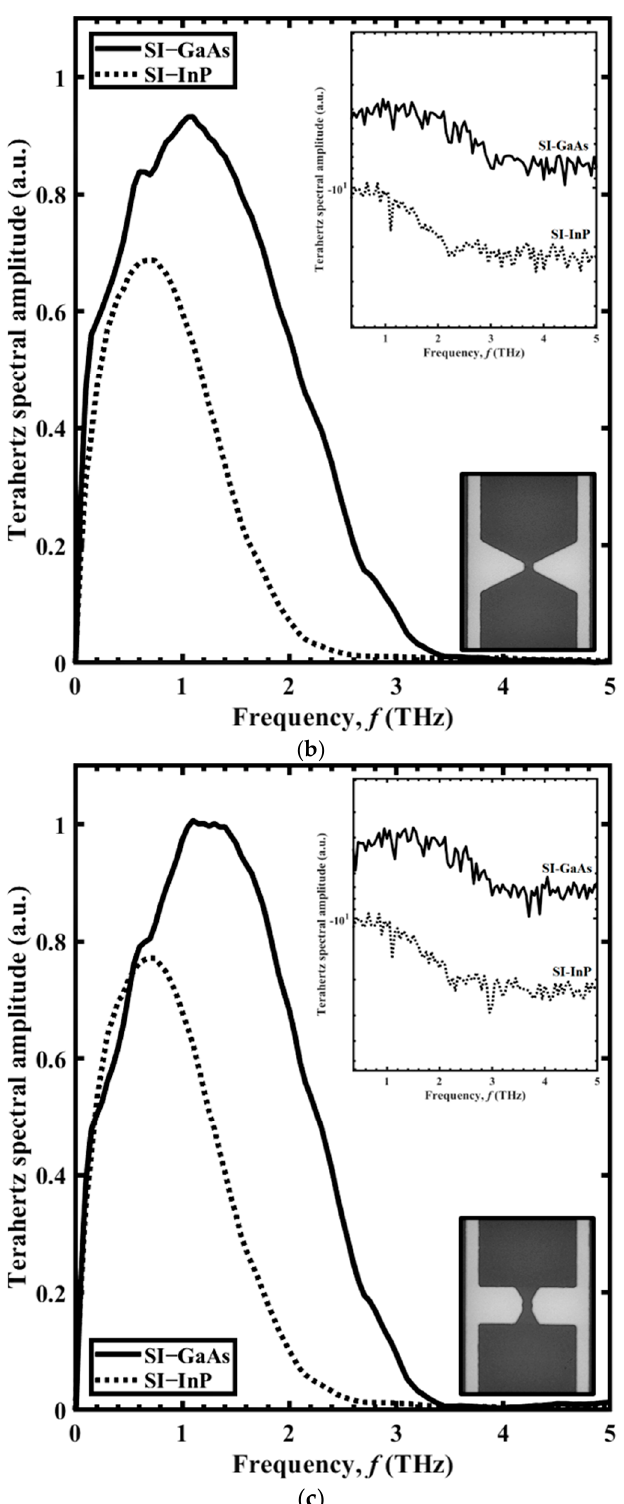
Figure 5. The THz spectral amplitude as a function of frequency, f, for PC THz emitters incorporating SI-GaAs (solid lines) and SI-InP (dotted lines) in the form of ( a ) Asymmetric BT, ( b ) Blunted BT, and ( c ) Doubled BT structures. The THz spectral amplitudes are shown on a log scale in the upper insets, and the three structures are shown as scanning electron microscope (SEM) images in the lower insets, with lighter colour denoting metal.